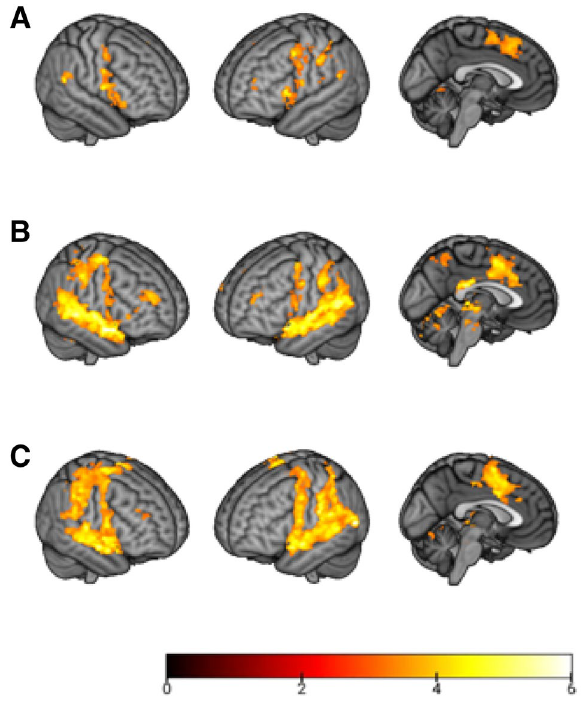
Figure 2. Group activation maps for experience of auditory hallucinations (A) and real speech (B) in 15 hallucinating patients. Activations to real speech in 15 non-hallucinating patients are shown in row (C) . Colour bar depicts Z